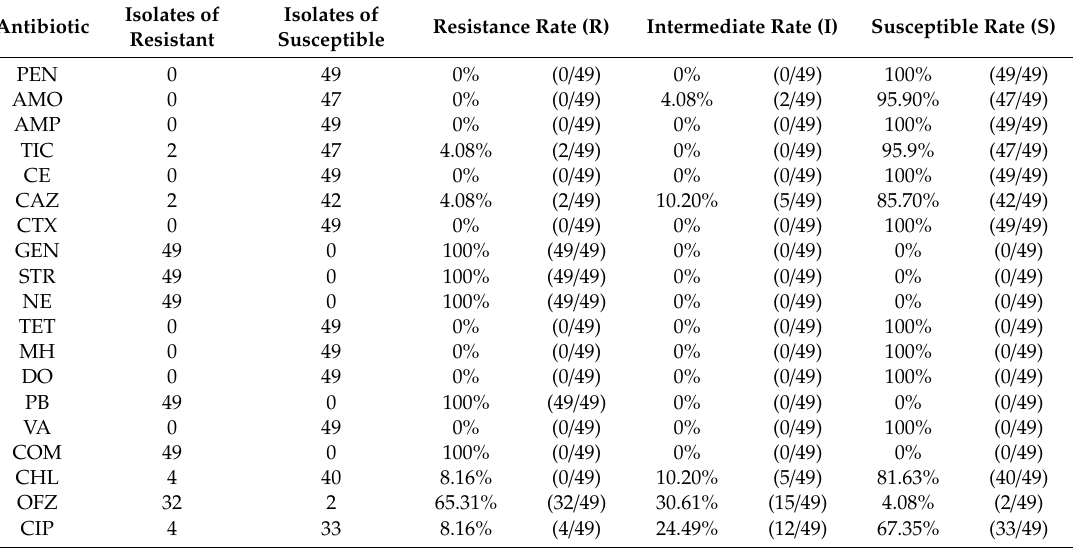
Table 1. Pharmacokinetic phenotypic test results of 49 strains of T.